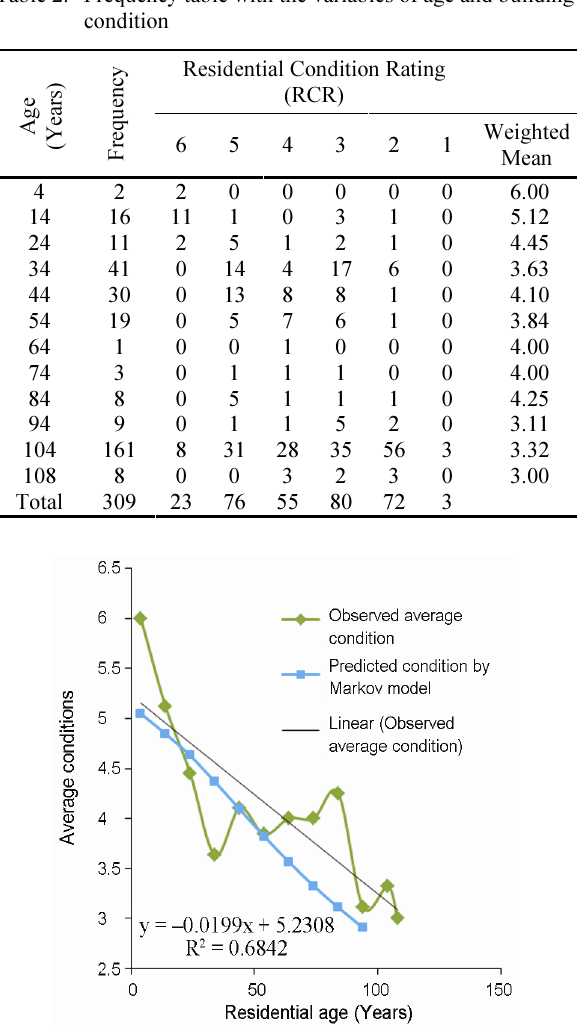
Fig. 8. Building condition rating versus building ages Table 2. Frequency table with the variables of age and building